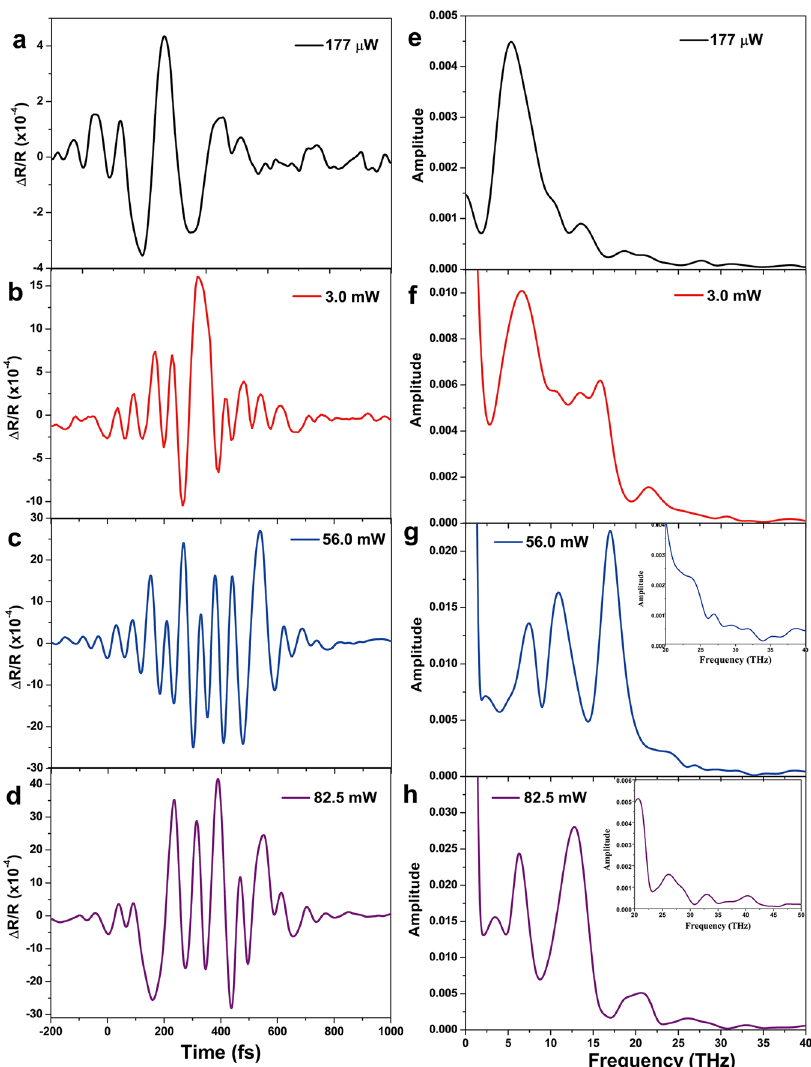
Fig. 1 Temporal oscillations and fast Fourier transform (FFT) spectra from colloidal quantum dots (CQDs) pumped at various powers by femtosecond pulse at 770 nm. a – d Differential transient re fl ectivity as function of delay time between pump and probe light; e – h Corresponding FFT spectra pumped at wavelength 770 nm with indicated powers (177 μ W, 3.0 mW etc.). Insert in g and h is the FFT spectrum at high frequency. R represents re fl ectivity, Δ R/R represents differential re fl ectivity, fs represents femotosecond, and THz is the acronym of TeraHertz, which is the frequency